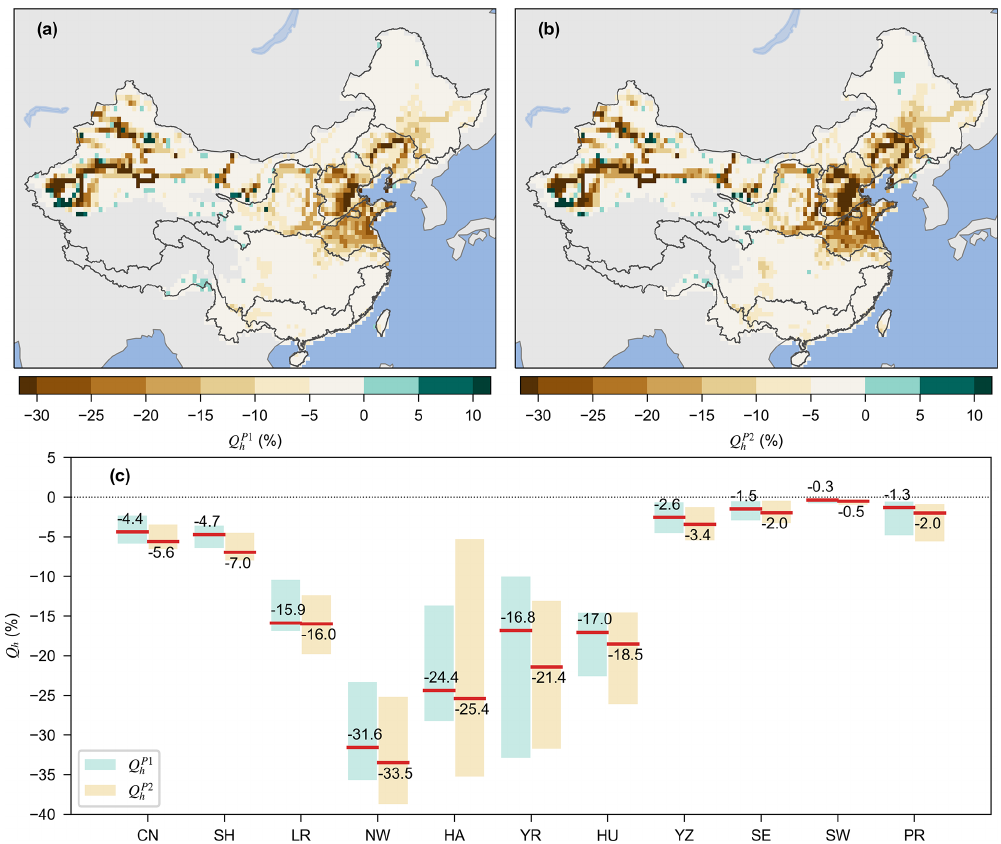
Figure 4. Long-term MAF altered by DHI. Ensemble medians of long-term MAF altered by DHI in (a) the sub-period 1971–1990 ( Q P1 and (b) the sub-period 1991–2010 ( Q P2 ), and (c) ensemble medians and ranges of averaged long-term MAF altered by DHI for each basin h and China (denoted by CN). In plot (c) , the range indicates the 25th and 75th values, and the numbers indicate the median values from all ensemble